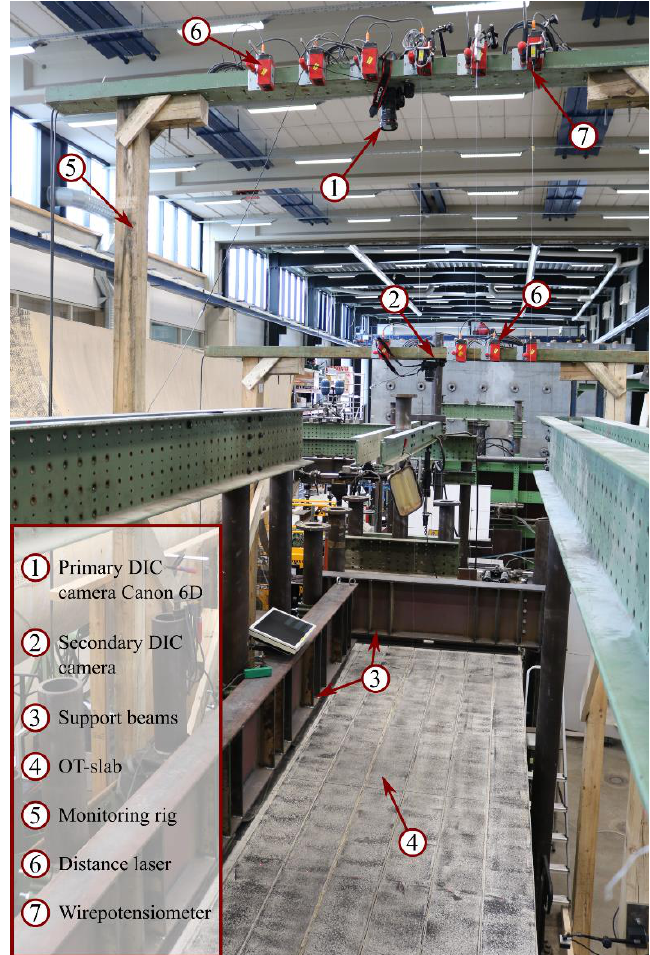
Figure 7. Test setup with monitoring rig separate from test setup.